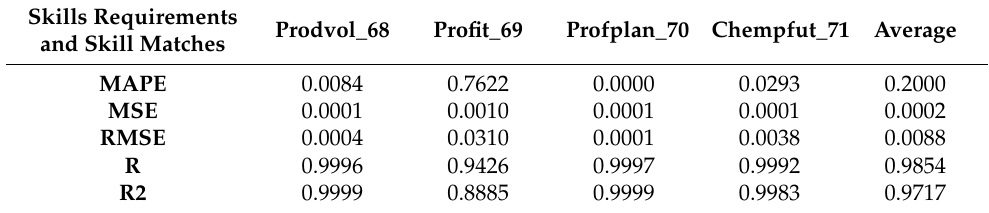
Table 8. Testing results for the effect of skills requirements and skill matches on firm performance.